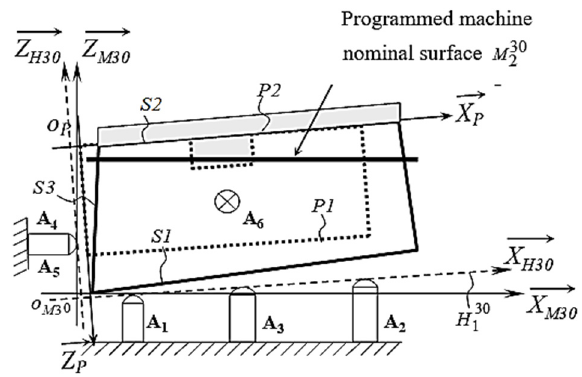
Figure 12. Part positioning in phase 30.